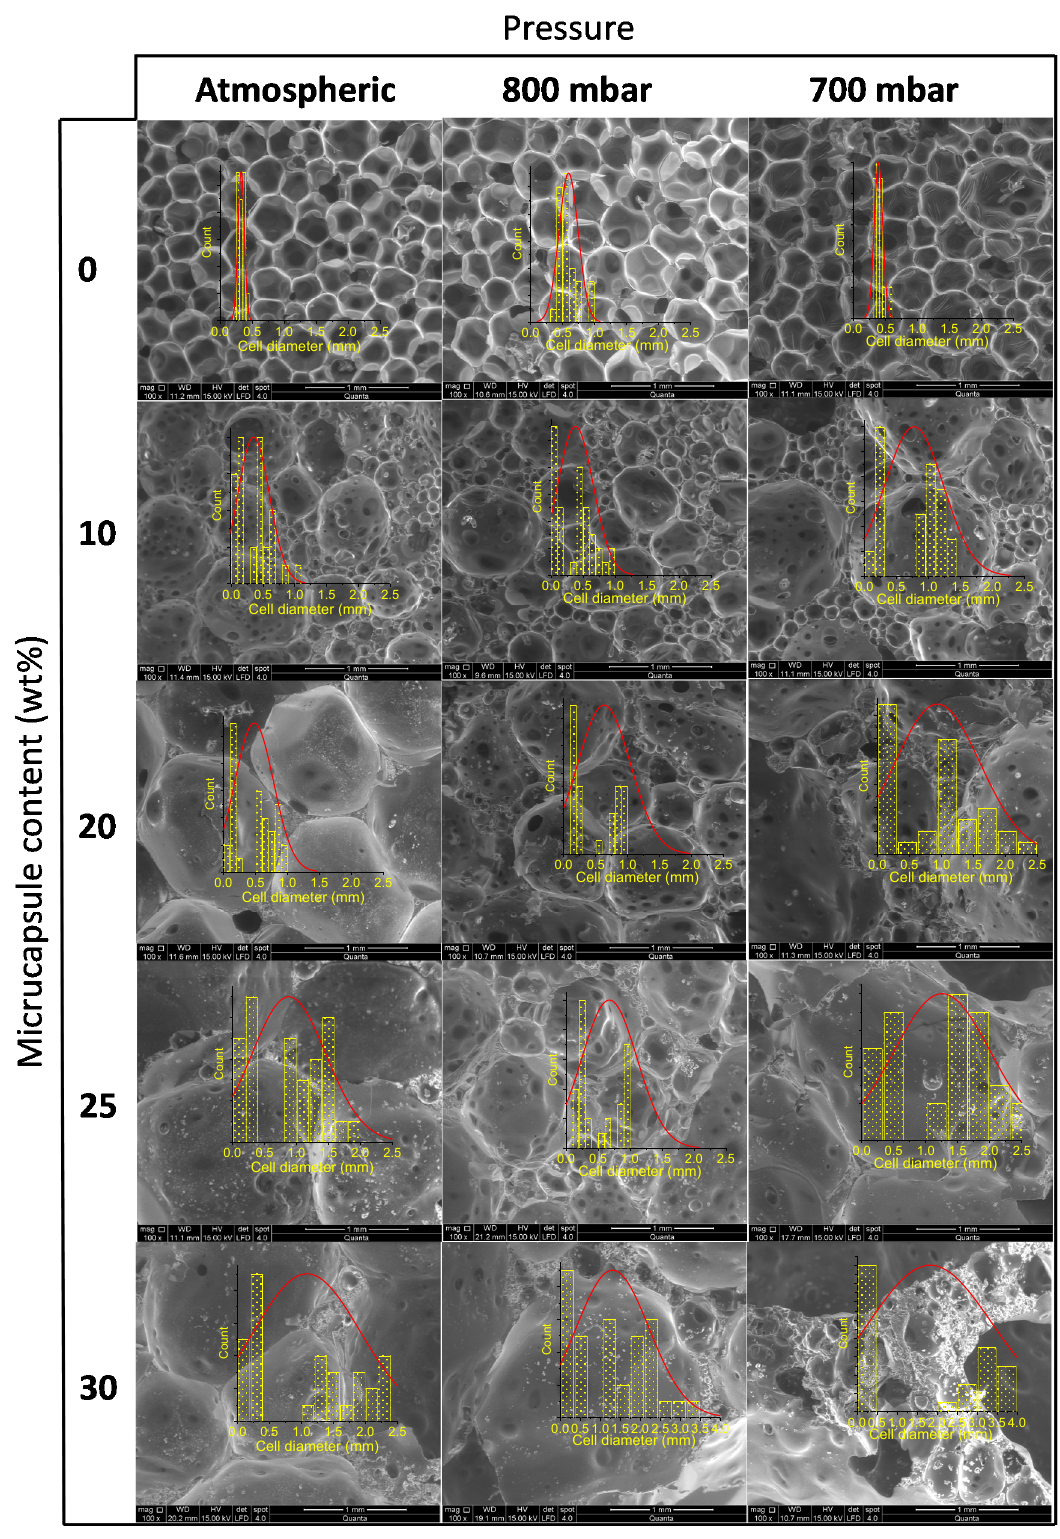
Figure 6. SEM photos of the internal foams synthesized under different pressures and contents of microcapsules.